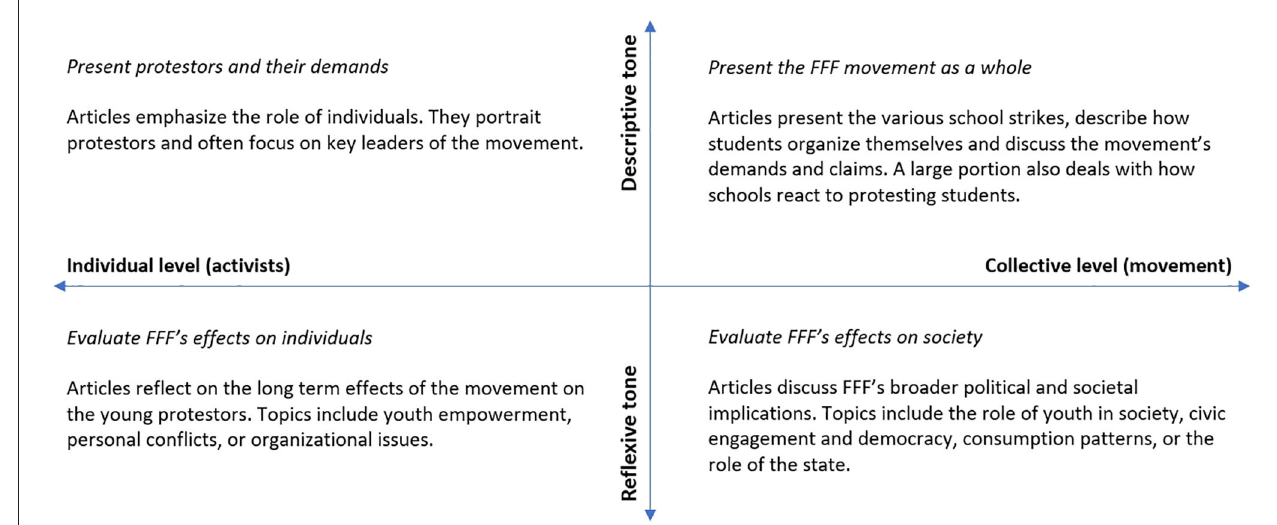
FIGURE 2 | FFF news coverage divided into individual/collective and descriptive/reflexive